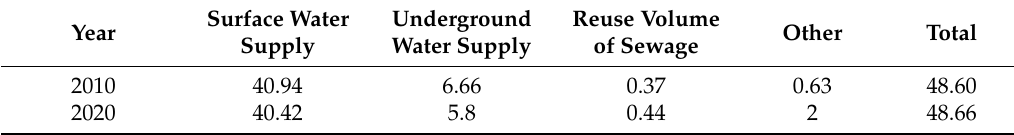
Table 2. The available water supply of Bayannur City in 2010 and 2020